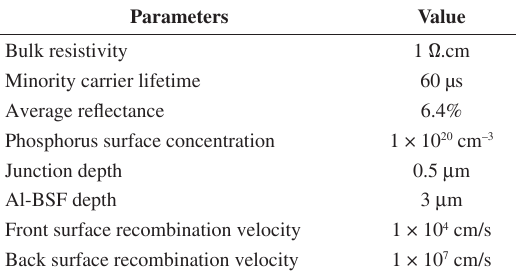
Table 1. Parameters for simulation of n + pn + and n + pp + solar cells. Parameters Value